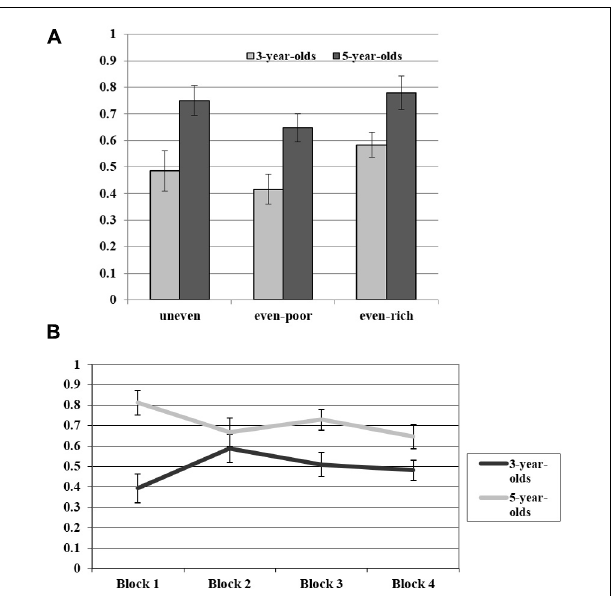
Experiment 2. Error bars indicate standard errors of the